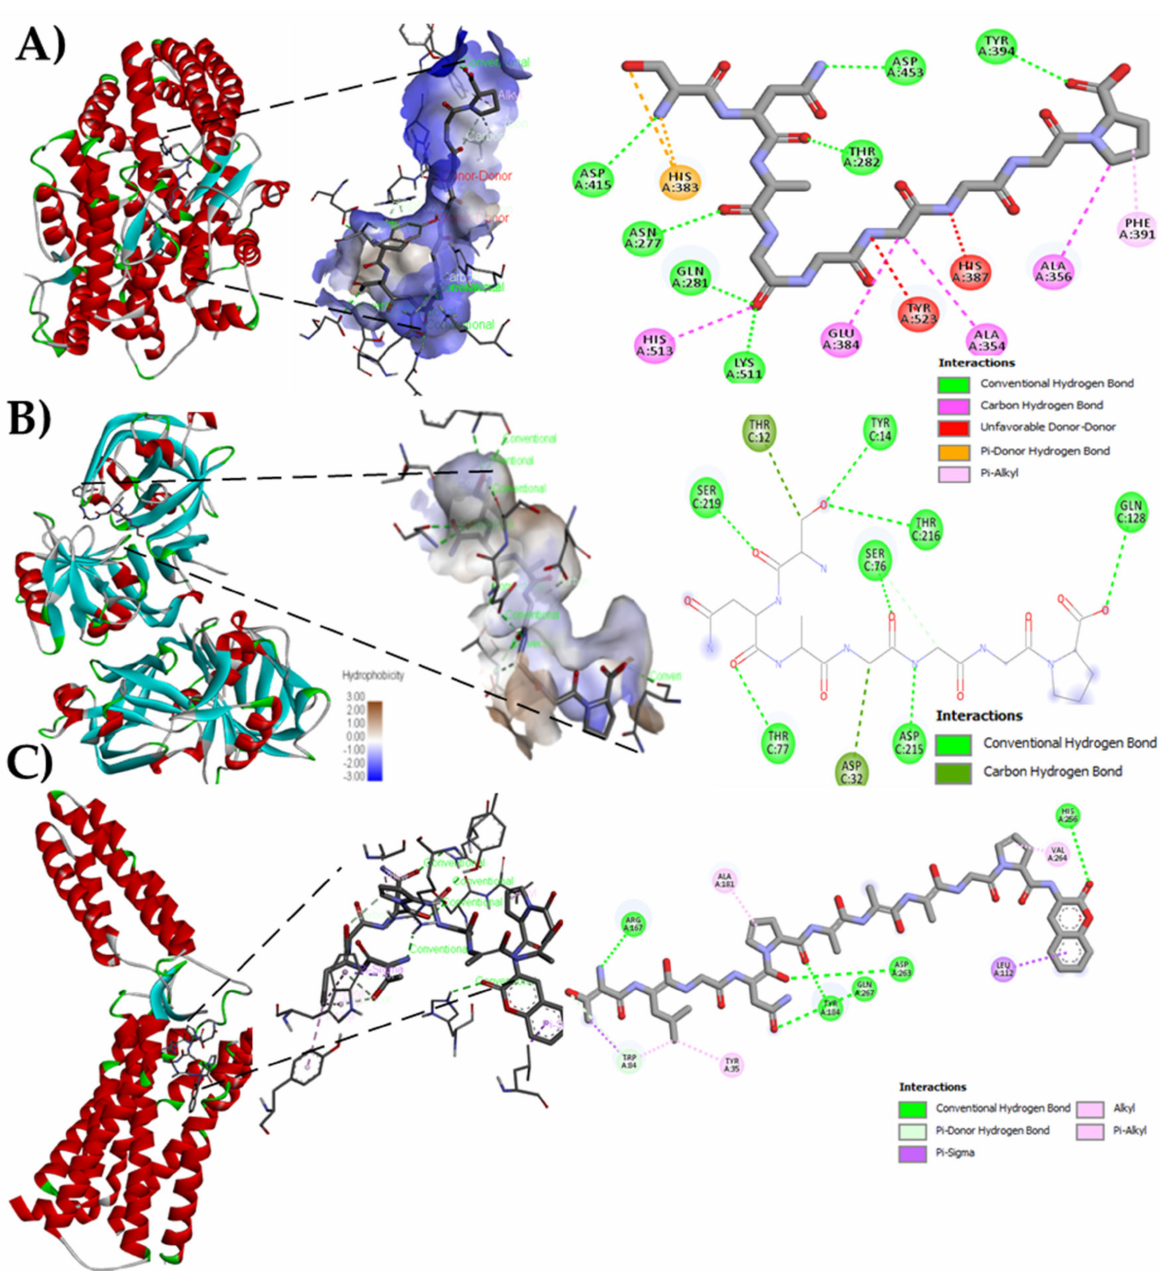
Figure 2. Molecular docking of native criollo peptides. ( A ) Molecular docking of peptide SNAGGGGGP with the An- giotensin Converting Enzyme (ACE) (PDB: ID 1086); ( B ) Molecular docking of peptide SNAGGGGGP with Renin (PDB: ID 2V0Z); ( C ) Molecular docking of peptide TLGNPAAAGPF with AT 1 -R (PDB: ID